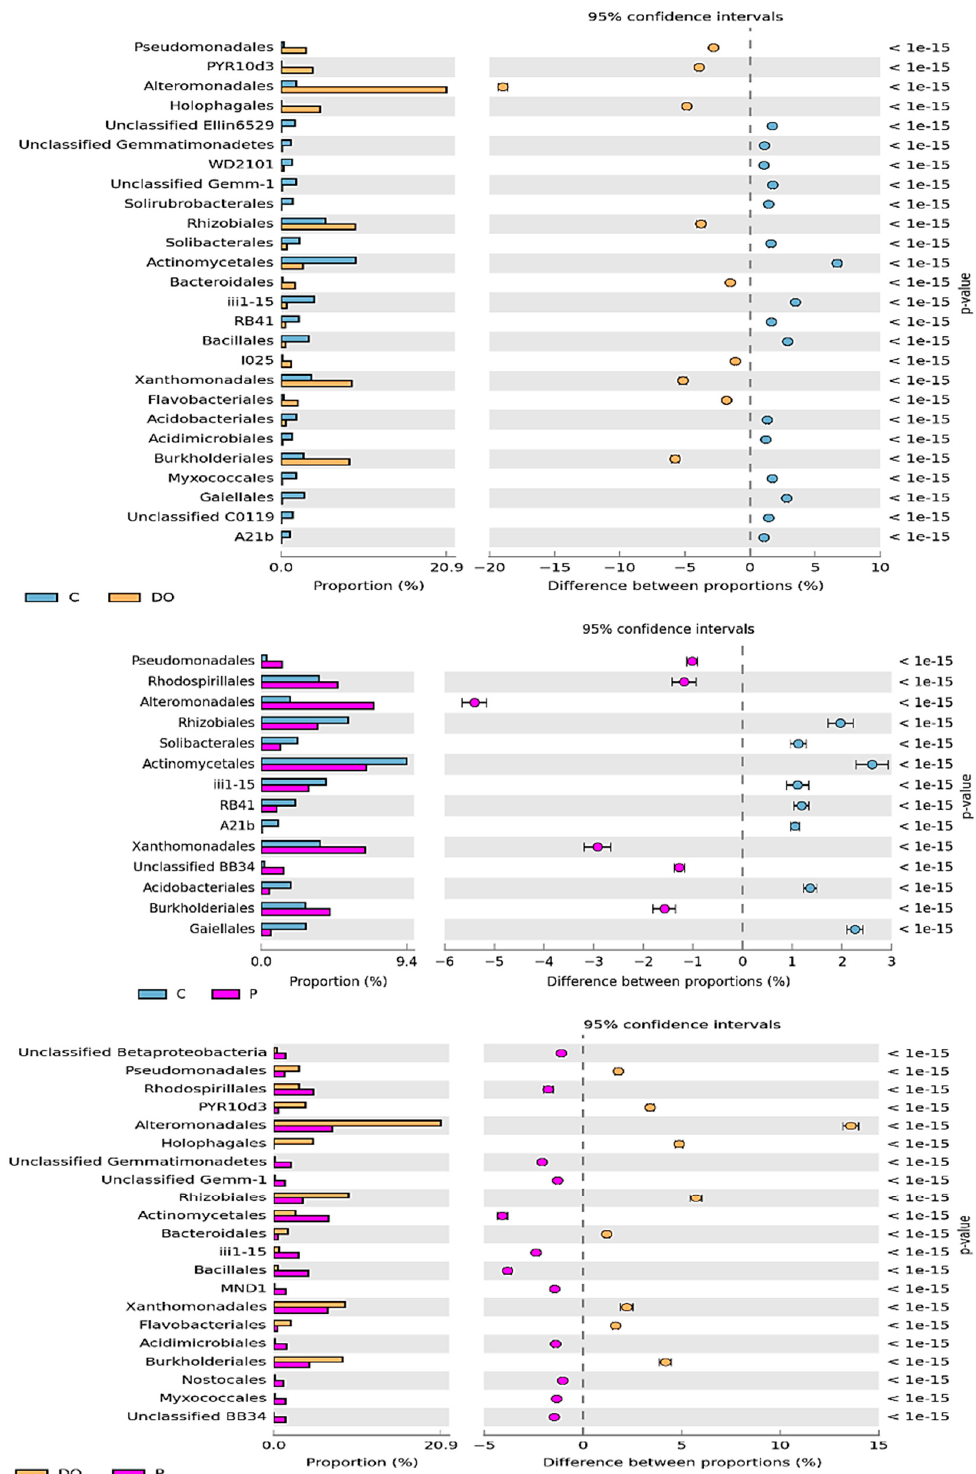
Figure 4. The relative abundance of dominant orders of bacteria in the soil with difference between proportions ≥ 1%. C—uncontaminated soil, DO—soil contaminated with diesel oil, P—soil contaminated with unleaded petroleum.